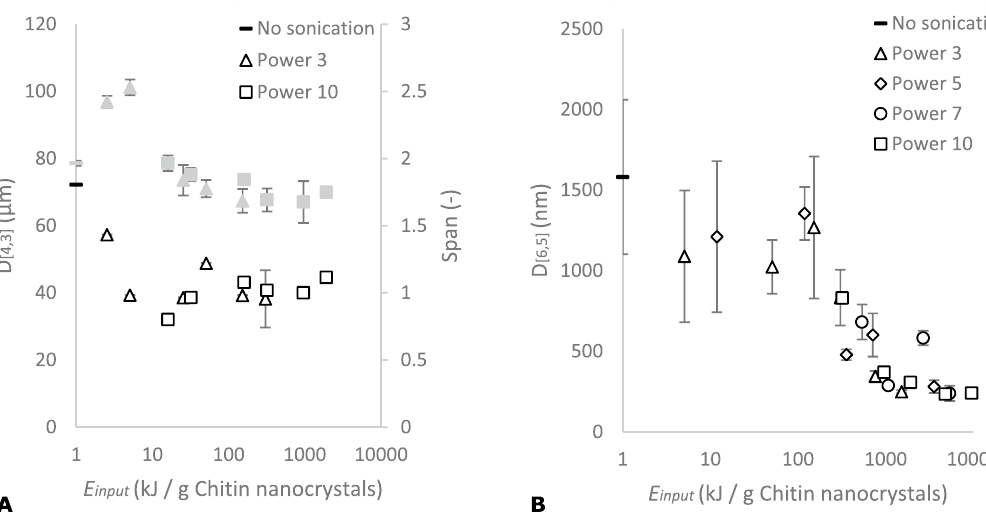
Figure 6. The chitin nanocrystal size (in white) and span (in grey) as function of ultrasound E input at different power settings measured with ( A ) laser diffraction and ( B ) dynamic light scattering. The error bars represent the standard deviation within three different measurements, some of them being within the data